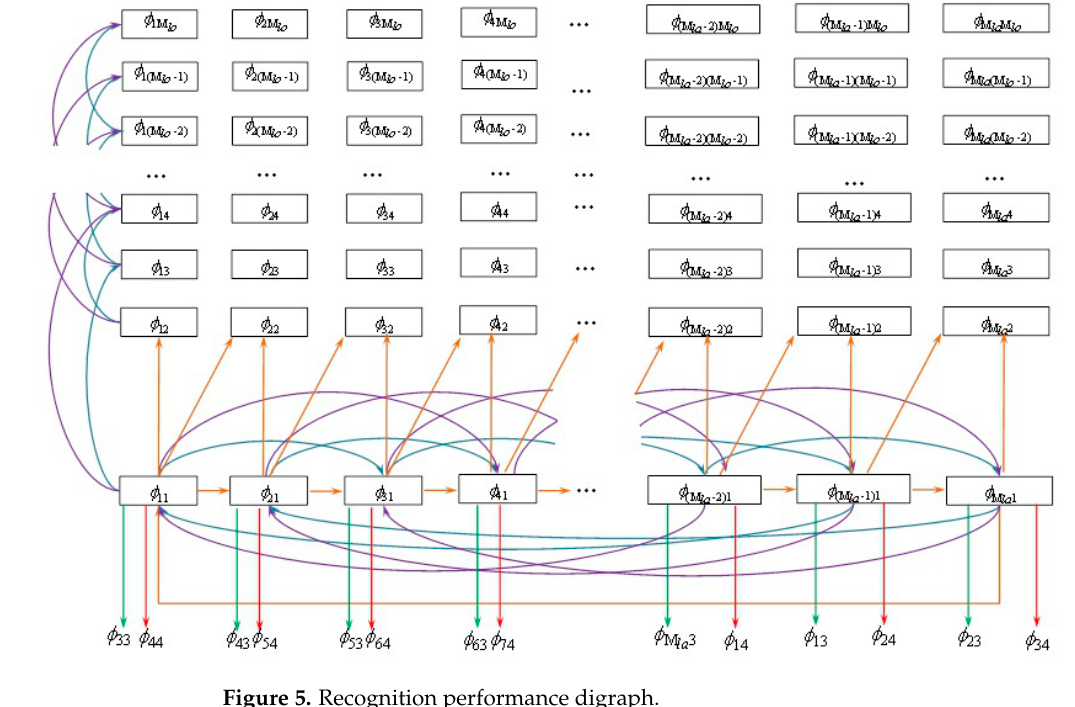
curve represents the direction at . d = 2, and the red line represents the direction diagonally at image pairs with different sets of view intervals R ˆ of the directed graph.